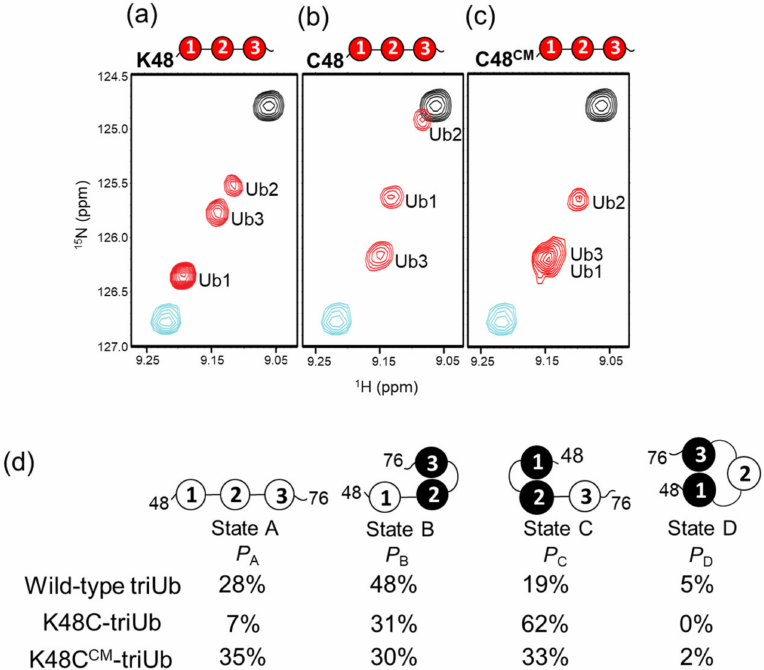
Figure 6. Allosteric propagation through the Ub chain. 1 H- 15 N HSQC peaks originating from Val70 of uniformly 15 N-labeled ( a ) wild-type triUb (red), ( b ) K48C-triUb (red), and ( c ) K48C CM -triUb (red). The peaks from monomeric Ub and c-diUb are plotted in cyan and black, respectively. The spectra were measured at 42 ◦ C in 10 mM sodium phosphate buffer, pH 7.0. ( d ) Cartoon model of the conformational equilibrium of triUb. The populations of States A, B, C, and D of triUb are denoted as P A , P B , P C , and P D , respectively. The calculated P A , P B , P C , and P D values of wild-type triUb, K48C-triUb, and K48C CM -triUb are